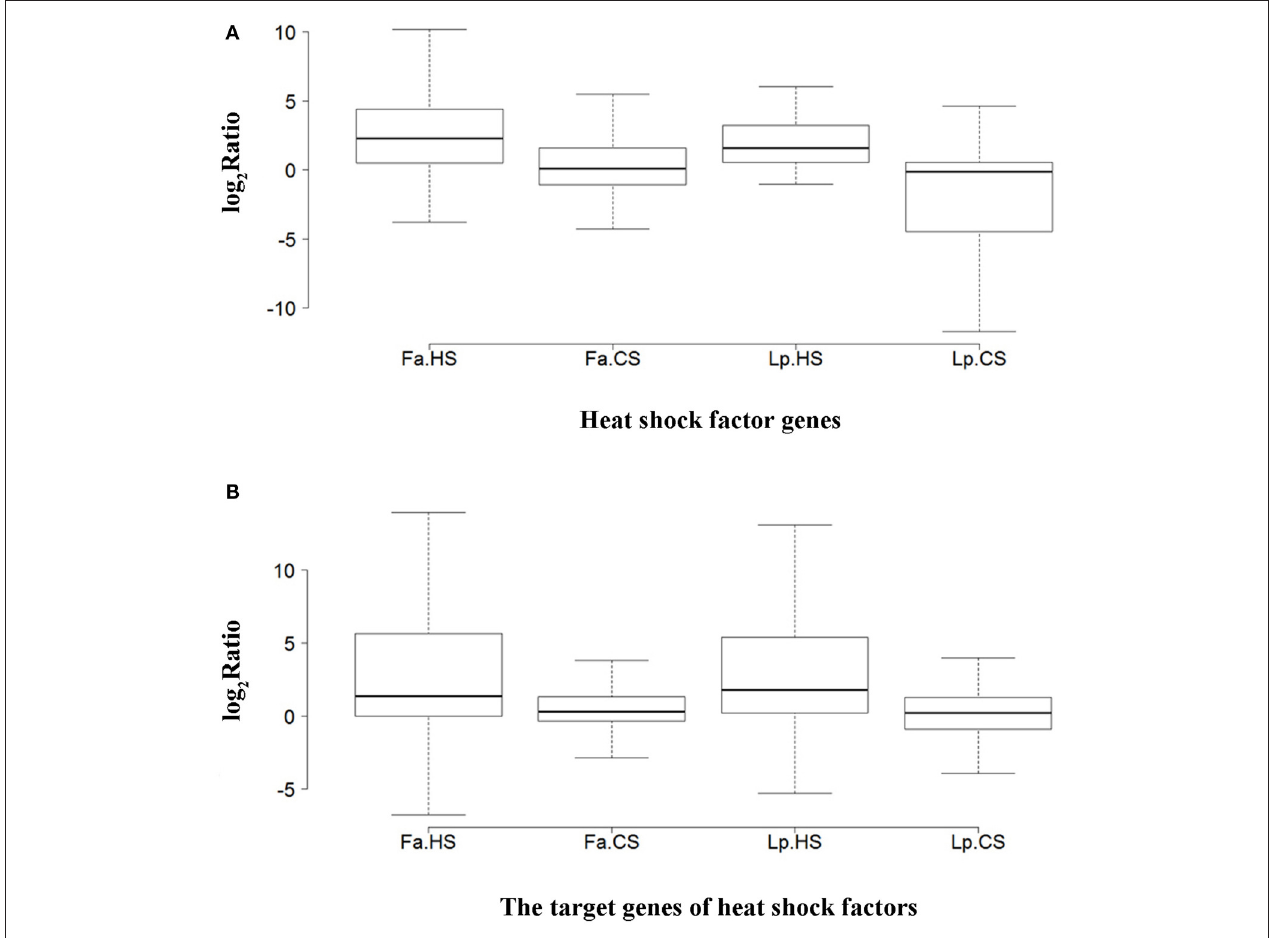
FIGURE 7 | Overall expression differences (log 2 Ratio) of heat shock factors and their target genes between species and stresses. (A) Heat shock factor genes. (B) The target genes of heat shock factors. Abbreviations are as follows: Fa, tall fescue ( Festuca arundinacea ); Lp, perennial ryegrass ( Lolium perenne ); HS, heat stress; and CS, cold stress. The log 2 Ratio represents the fold-change of Hsf FPKM values under heat or cold treatment relative to that of the control